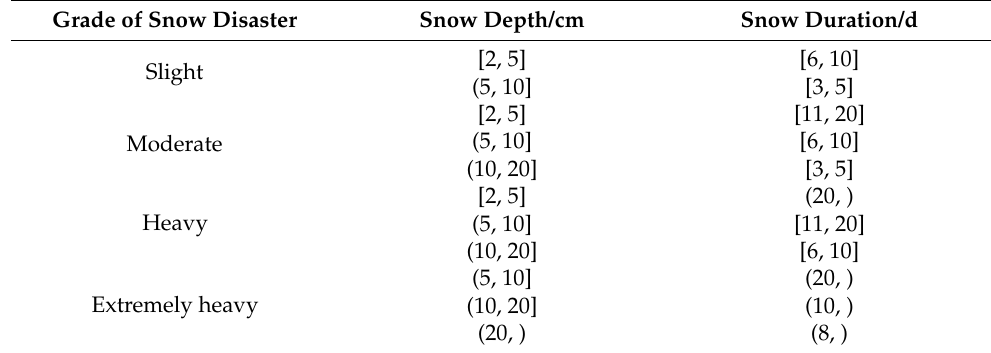
Table 2. Division criteria for snow disasters of this